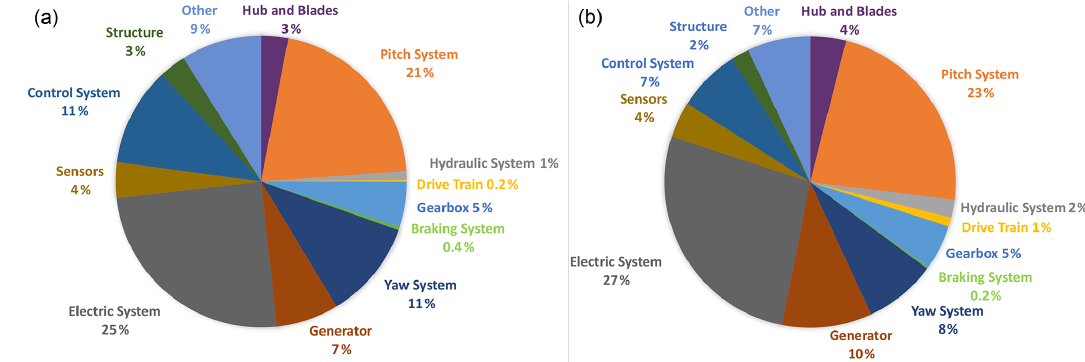
Figure 1. Failure rate (a) and downtime (b) from various turbine subsystems. Figure generated from Reliawind report data (Wilkinson and Hassan,